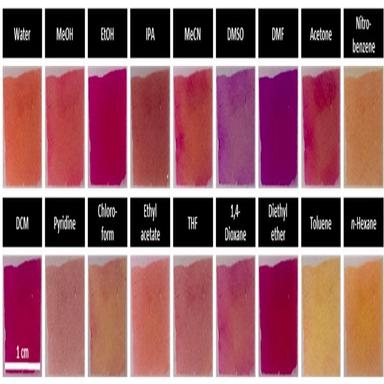
Colorimetric responses of the modified nanofiber sheet (approx. 1 × 1 cm sheet) tested in solvents with different polarities. The solvents are ordered with decreasing polarity according to the EN T polarity scale.